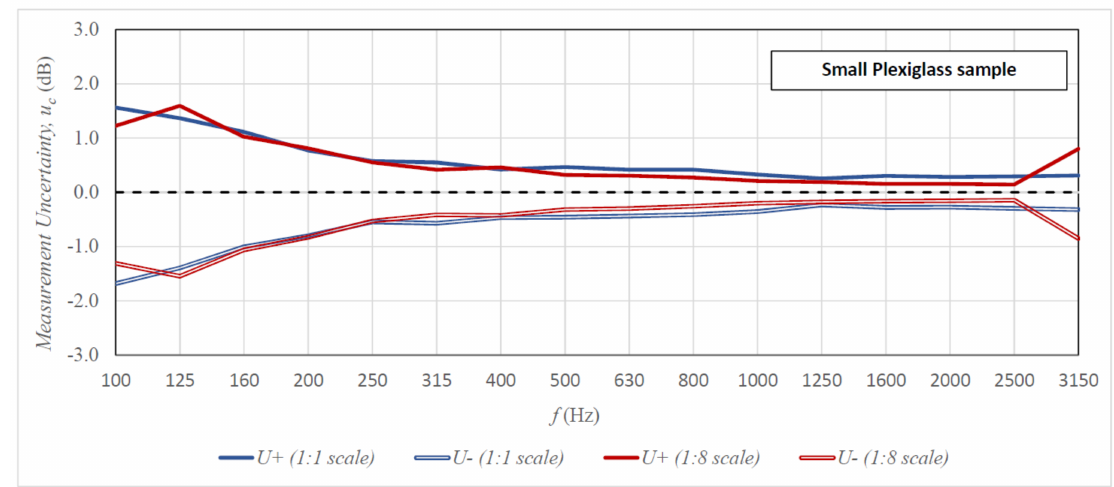
Figure 7. Uncertainty of sound insulation measurement for the 0.7 × 0.7 m plexiglass specimen (1:1 scale stand)/87.5 × 87.5 mm (1:8 scale stand) as a function of frequency for the 10-element measurement samples; the results from the scaled rooms were scaled to actual measurement